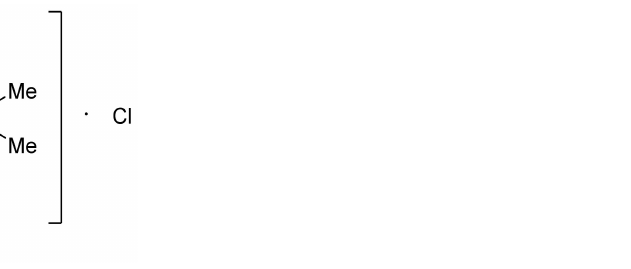
Figure 5. The structure of 2-propanone- N -[4-(ethylthio)-1,3-thiazol-2-yl]hydrazone hydrochloride ( 32 ).